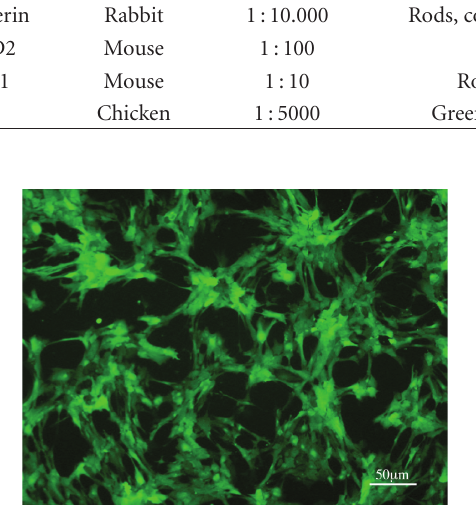
Figure 1: Donor porcine retinal progenitor cells (RPCs). RPCs isolated from GFP-transgenic donors at 45d gestational age and expanded in culture in the presence of EGF and bFGF. The cells grew as a monolayer and strongly expressed the GFP reporter gene. No tendency toward rosette formation is seen.